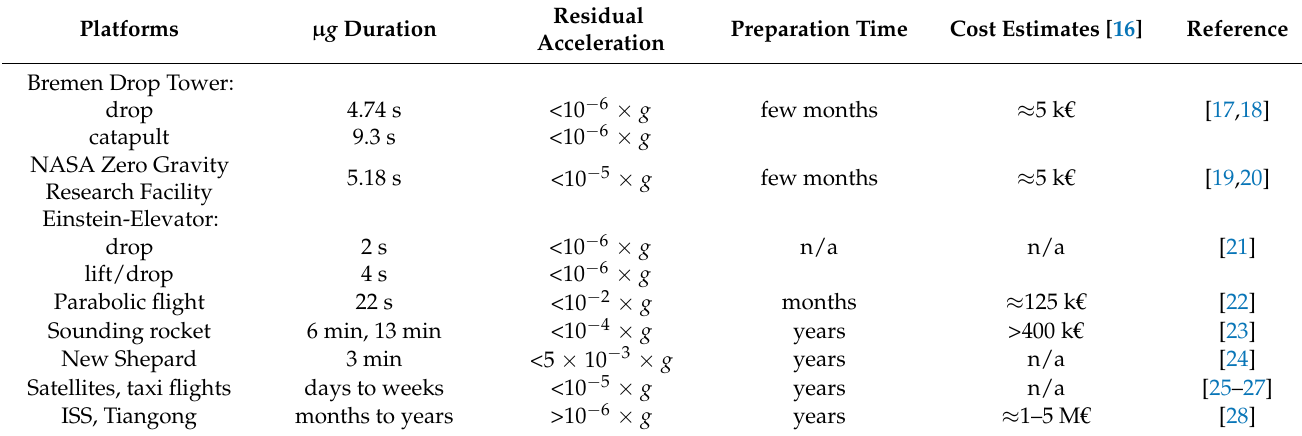
Table 1. Key parameters of different microgravity